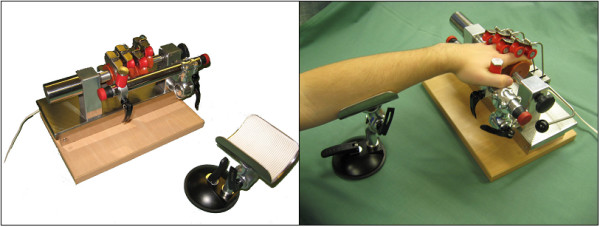
The Finger Trainer, "Reha-Digit", without a patient (left), and a left-hemiparetic patient practicing with the device (right).